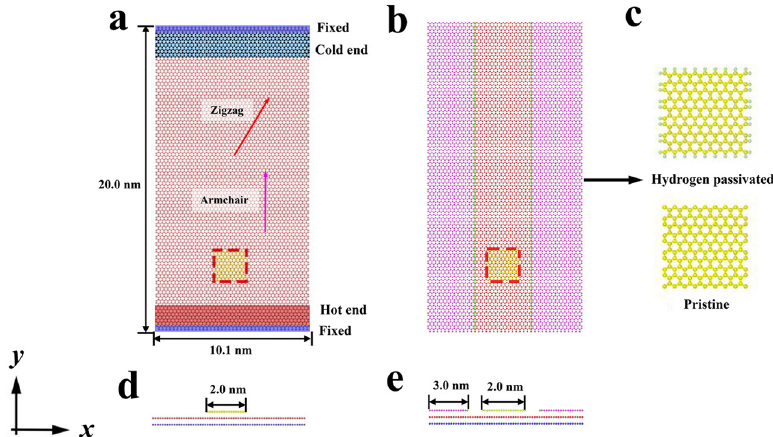
Figure 1. The setup of models. The vertical ( a ) and side ( d ) views of the model without channel; ( b , e ) were the vertical and front views of the model with graphene channel. The brown and blue balls denoted graphene substrates. The purple balls denoted the graphene sheet that forms the channel. The green–yellow atoms were hydrogen atoms and carbon atoms of graphene nanoflake. ( c ) The pristine and hydrogen-passivated graphene